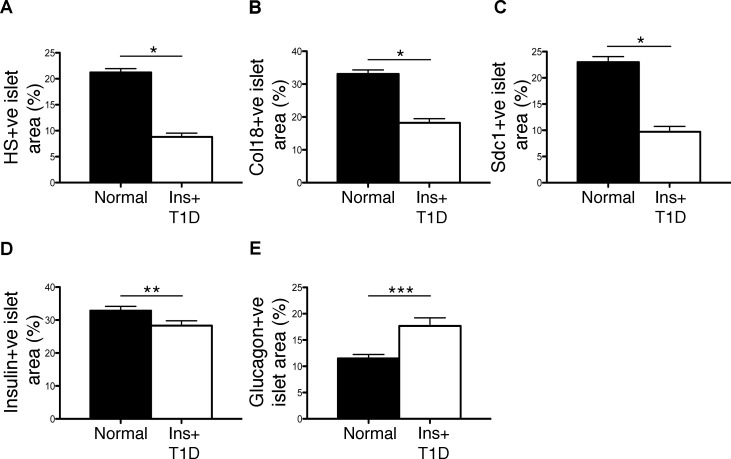
Intra-islet HS and HSPG core protein levels decline in Ins+ islets in human T1D.Morphometric analysis of the (A) HS-positive, (B) Col18-positive, (C) Sdc1-positive, (D) insulin-positive and (E) glucagon-positive islet area in normal human pancreases (black bars) and Ins+ T1D human pancreases (open bars). Data shows mean ± SEM; n = 6–8 pancreases (n = 56–80 islets) examined/group for normal controls and n = 6–8 pancreases (n = 52–66 islets)/group for Ins+ diabetic donors, except for analyses of Sdc1 where n = 4–5 pancreases (n = 40–42 islets) were examined/group. Significance was determined using unpaired Student’s t test, * = P<0.0001, ** = P = 0.0217 and Mann-Whitney test, *** P = 0.0025.